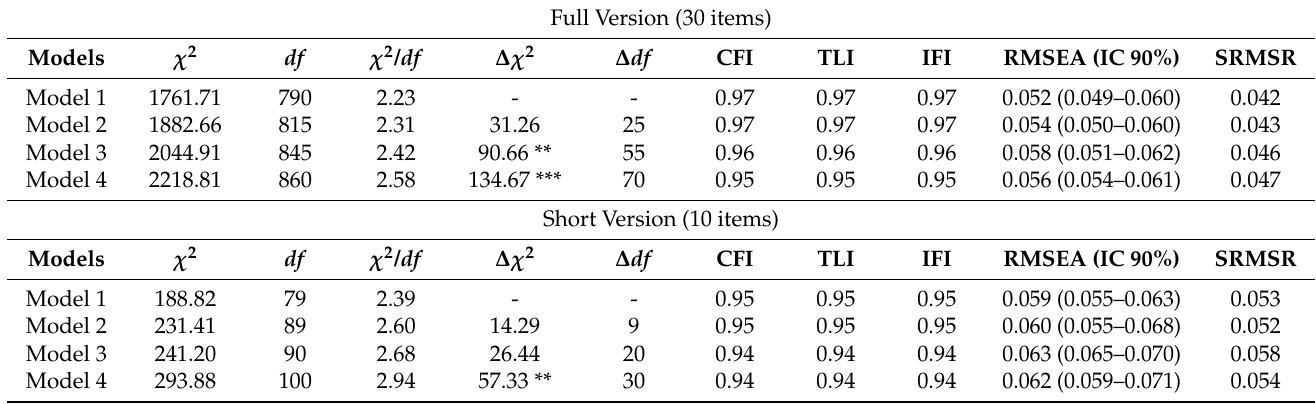
Table 1. Gender Invariance Analysis.